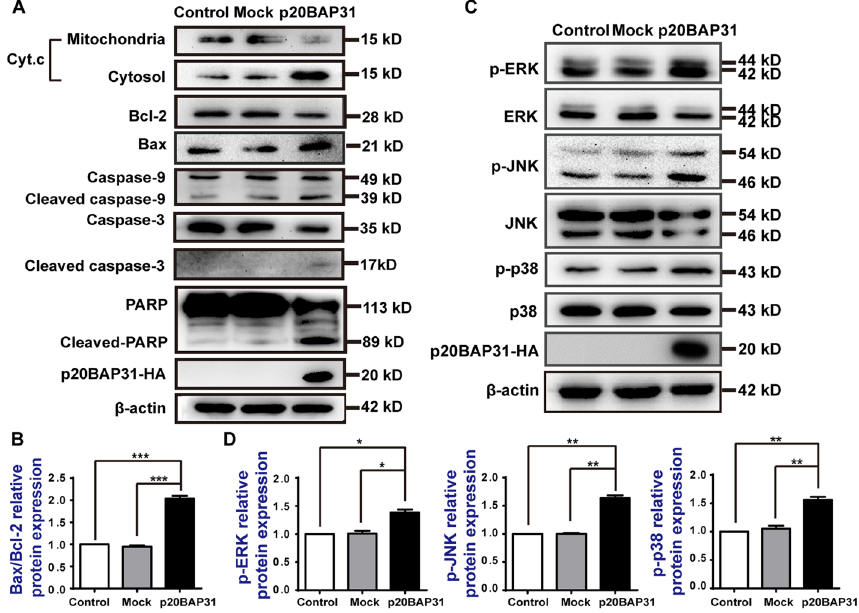
Fig. 4 p20BAP31 induces mitochondrial apoptosis by activating the MAPK signaling pathway. A The expression levels of Bcl-2, Bax, caspase-3, cleaved caspase-3, PARP, cleaved PARP, caspase-9, cleaved caspase-9, and cyt.c proteins in HCT116 cells were determined by western blot after transfection with p20BAP31 for 48 h. B Relative quantity analysis of Bax/Bcl-2 in HCT116 cells. C Western blotting was used to detect p-ERK, ERK, p-JNK, JNK, p-p38, and p38 levels in HCT116 cells transfected with p20BAP31 for 48 h. D The relative quantification of the protein levels was analyzed by ImageJ software. * P < 0.05, ** P < 0.01 and *** P <